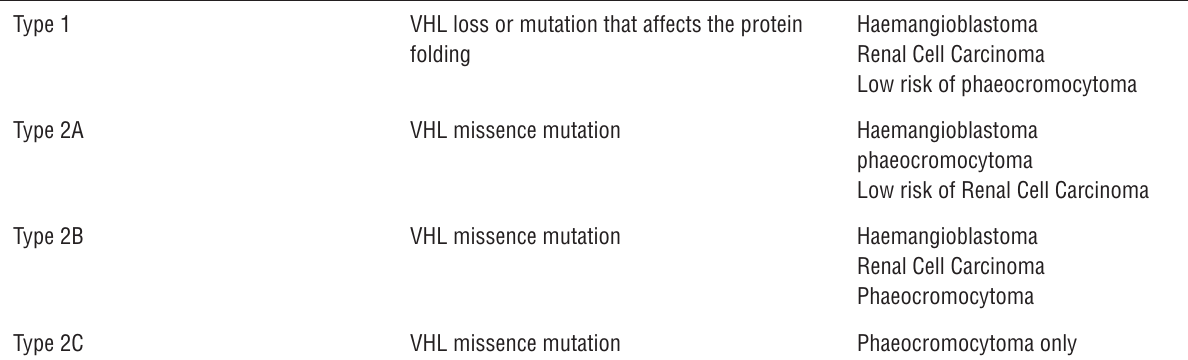
Table 1 - Type and characteristics of vHL genetic